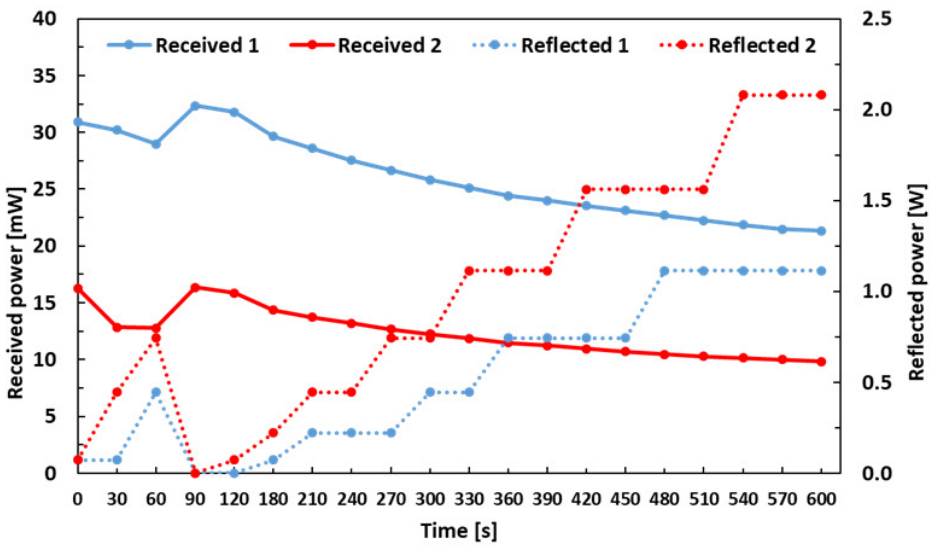
Figure 7. Received and reflected power vs. time for 50 W MWA in SP.